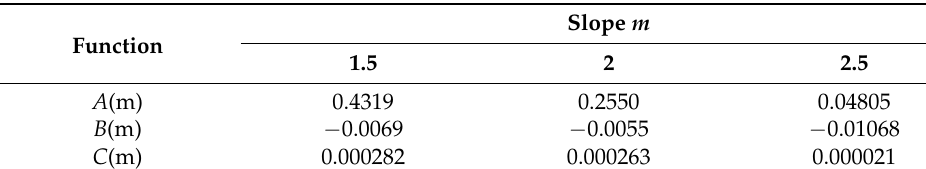
Table 6. Fitting coefficients.